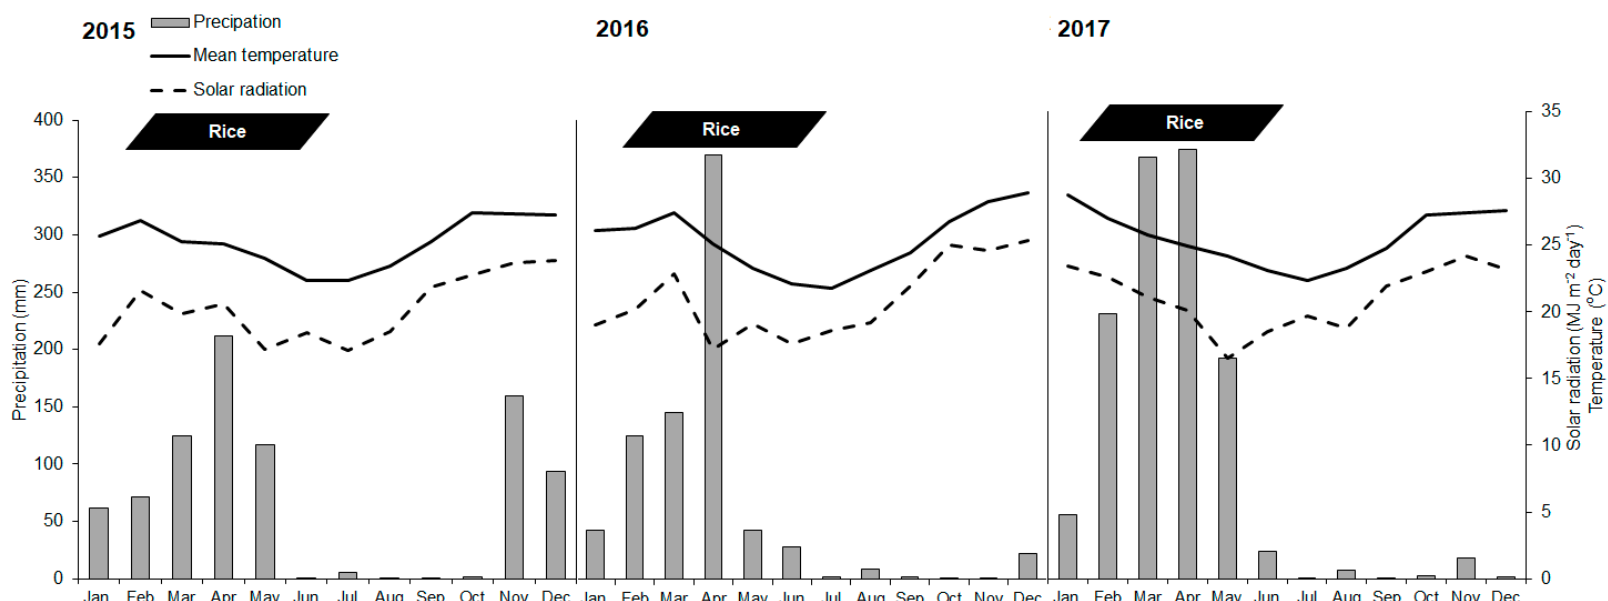
Figure 2. Meteorological data for Ifakara (261 m a.s.l) for 2015, 2016 and 2017, showing monthly total rainfall (solid bars), average daily mean temperature (solid line) and average daily total solar radiation (dotted line). Rice was transplanted from late February to early March and harvested between early and late June with rainfall of 453 mm, 582 mm and 941 mm during the growing period from March to May (of 2015, 2016 and 2017, respectively).